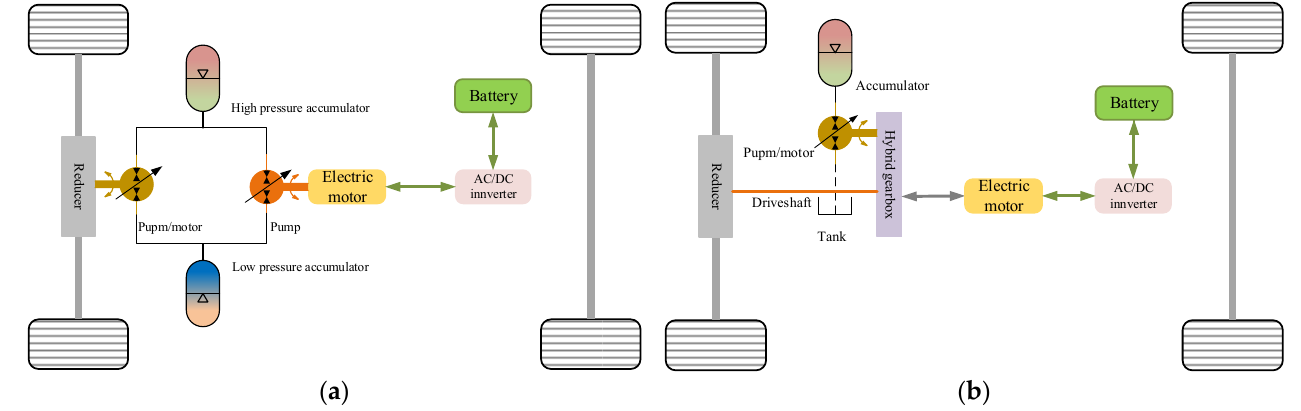
Figure 3. General principle of hydraulic energy regeneration and conversion technologies [55,62–65]: ( a ) common pressure rail (CPR); ( b ) variable pressure rail (VPR).